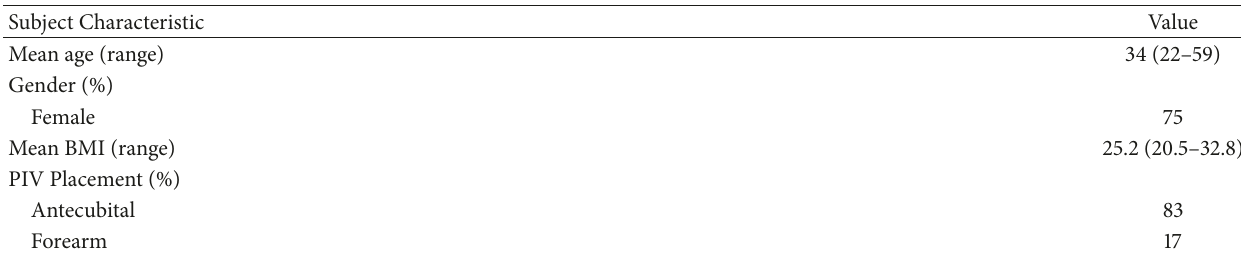
Table 3: Demographics.